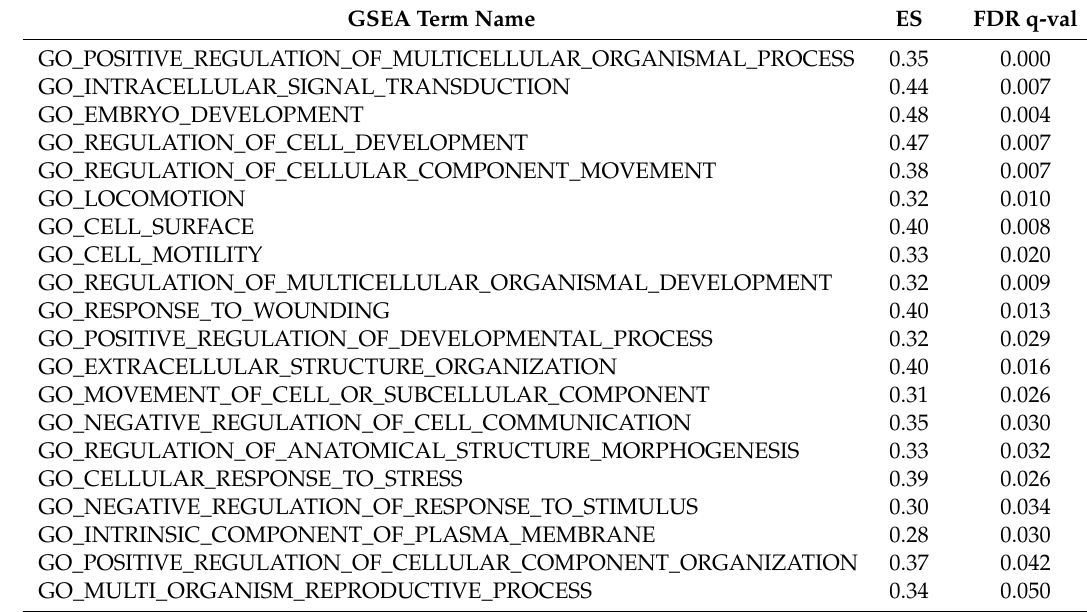
Table 4. Upregulated gene sets (GSEA) of PBMCs treated with the DL-PCB